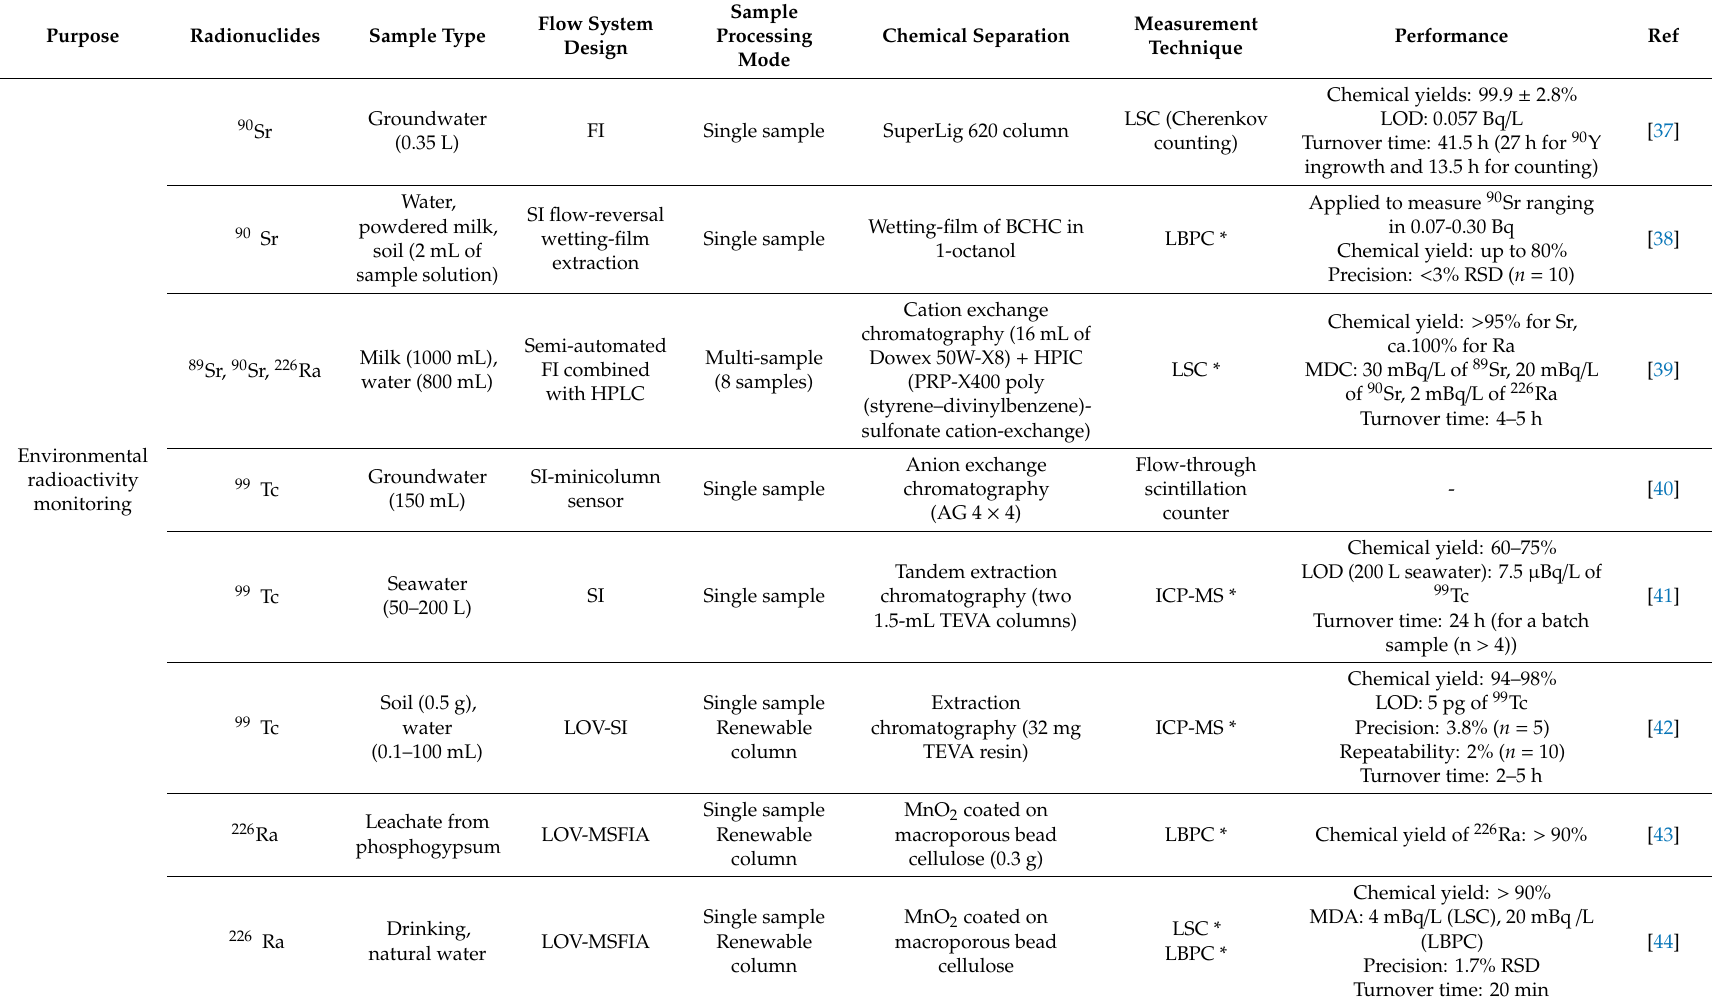
Table 1. Overview of flow approaches developed for radionuclide